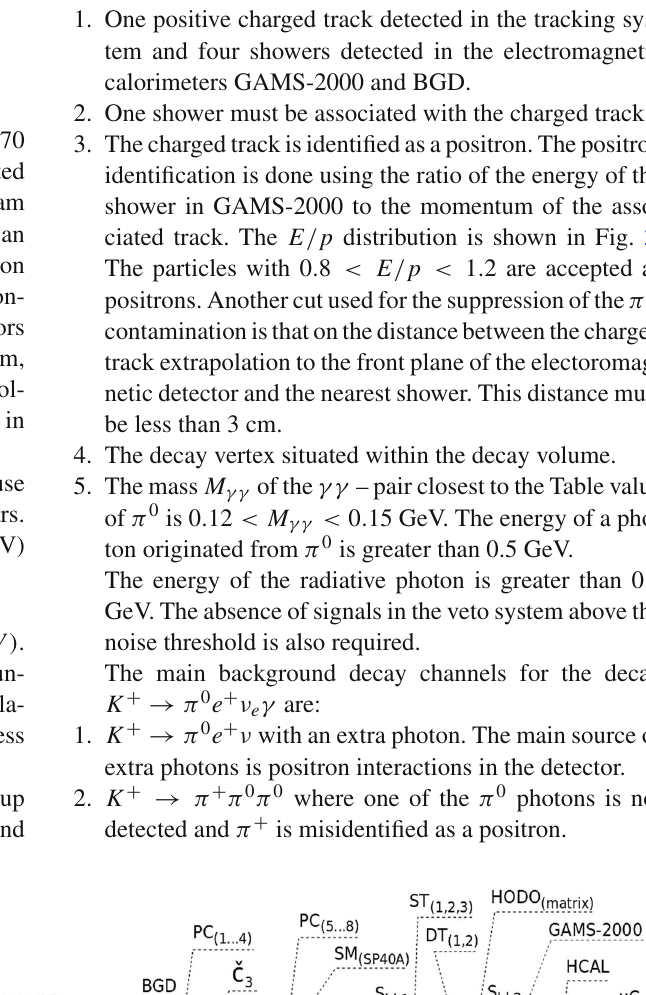
Fig. 1 Diagrams describing K + → π 0 e + νγ decay